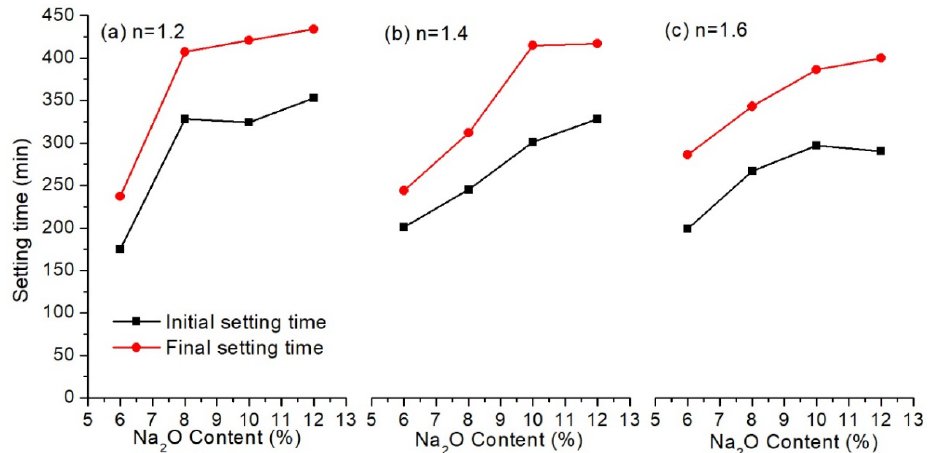
Figure 3. Setting time of alkali activated LFA-GGBS hybrid binder with different alkali solutions (GGBS content = 25%, water/solid ratio = 0.4): ( a ) modulus of water glass n = 1.2; ( b ) modulus of water glass n = 1.4; ( c ) modulus of water glass n = 1.6.